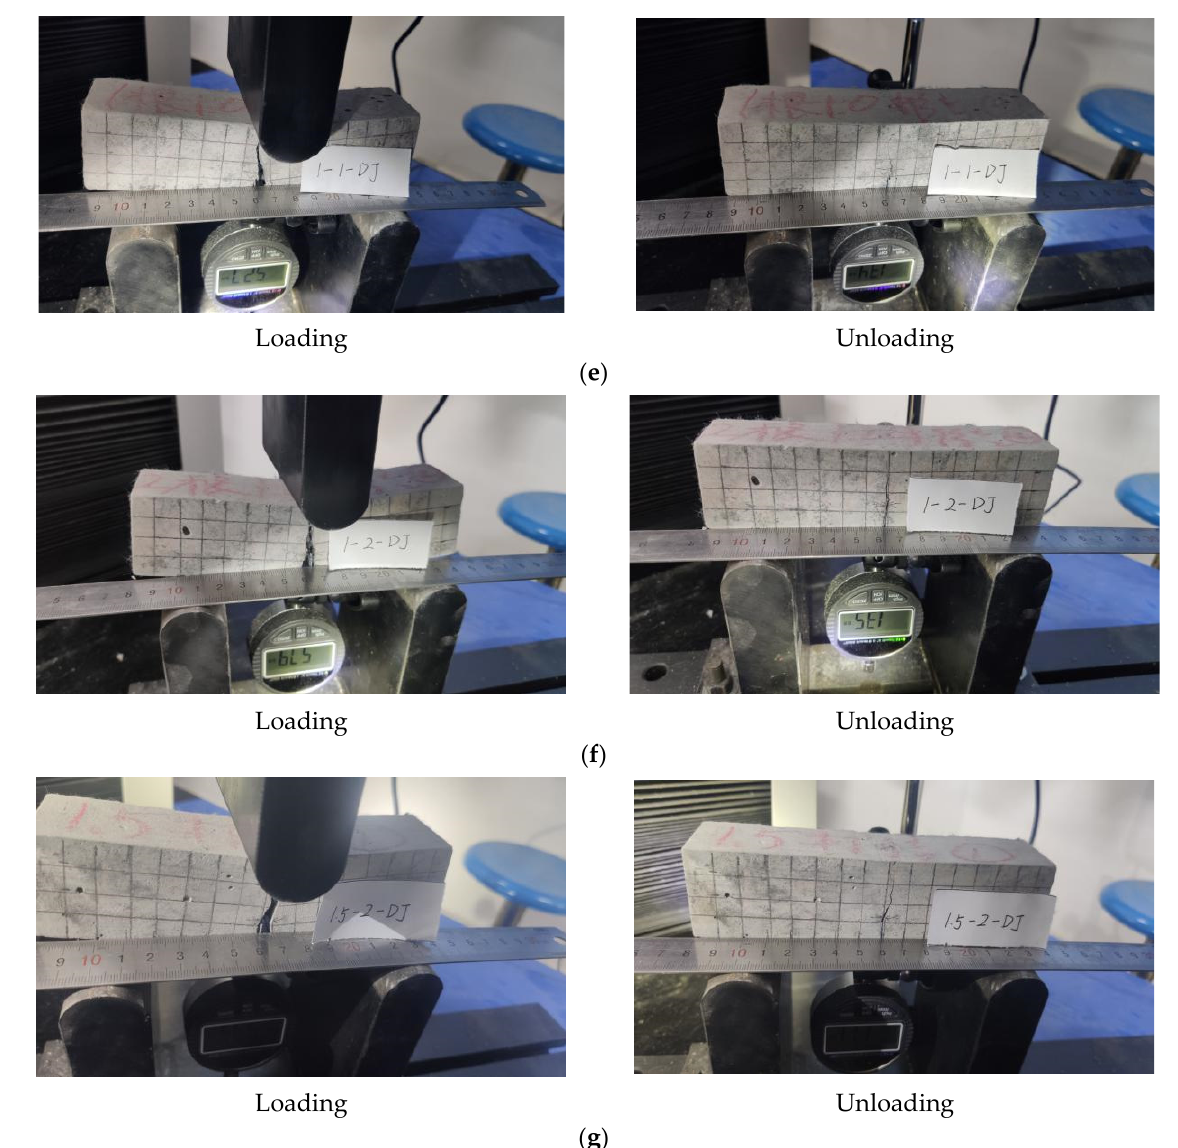
Figure 9. The failure phenomenon in the 10th loading cycle: ( a ) Comparison specimen E0; ( b ) Specimen 1.0-2-G; ( c ) Specimen 1.0-2-Z; ( d ) Specimen 0.7-2-DJ; ( e ) Specimen 1.0-1-DJ; ( f ) Specimen 1.0-2-DJ; ( g ) Specimen 1.5-2-DJ.